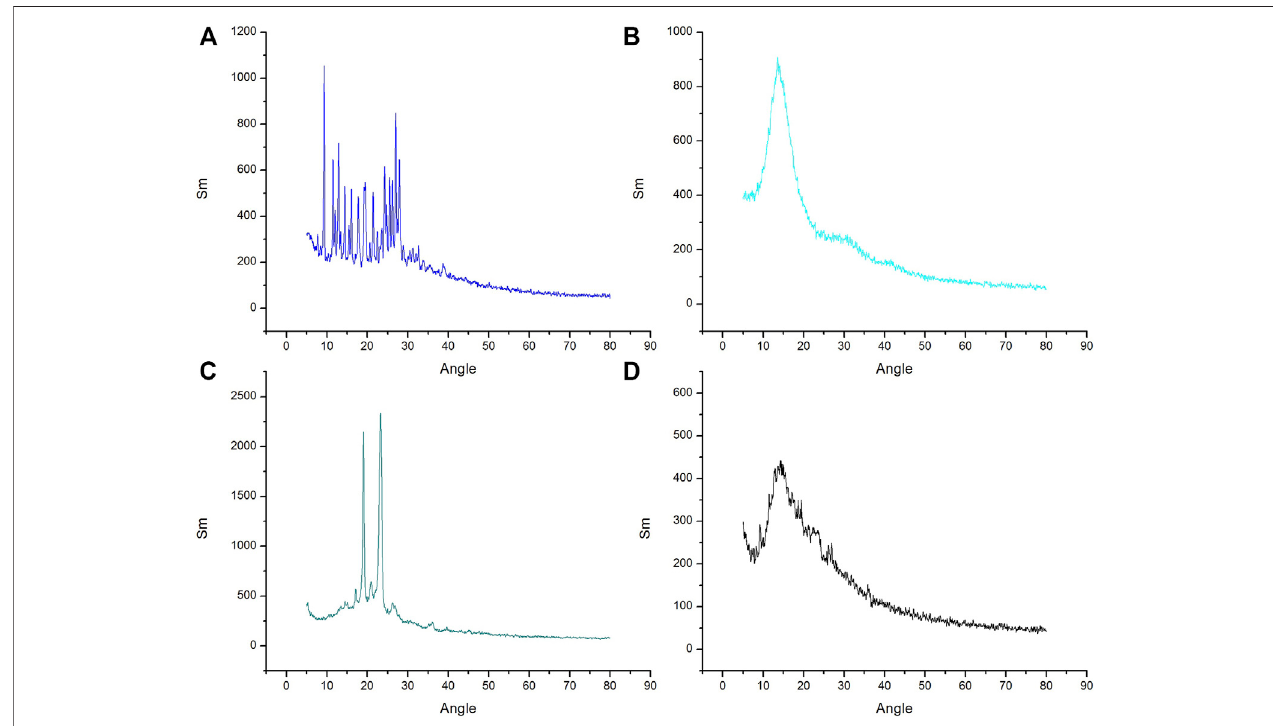
FIGURE 4 | XRD curve of (A) MTX, (B) Eudragit S100 (C) Poloxamer-407 and (D) MTX- Eudragit S100 nanoparticles (MSX8).